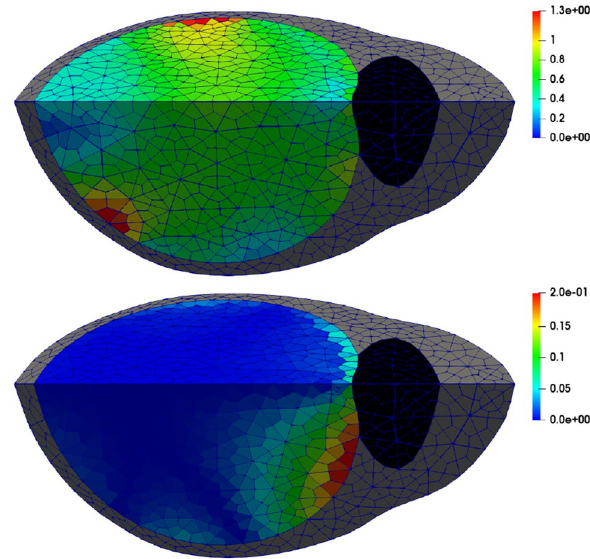
Fig. 12 Average norm per cell of the transformed Cauchy stress tensor ̂ J ̂ 𝕋 f ̂ F − T in the vitreous for the Burgers (top) and the Navier– Stokes (bottom) case. The domain is cut vertically for visualization